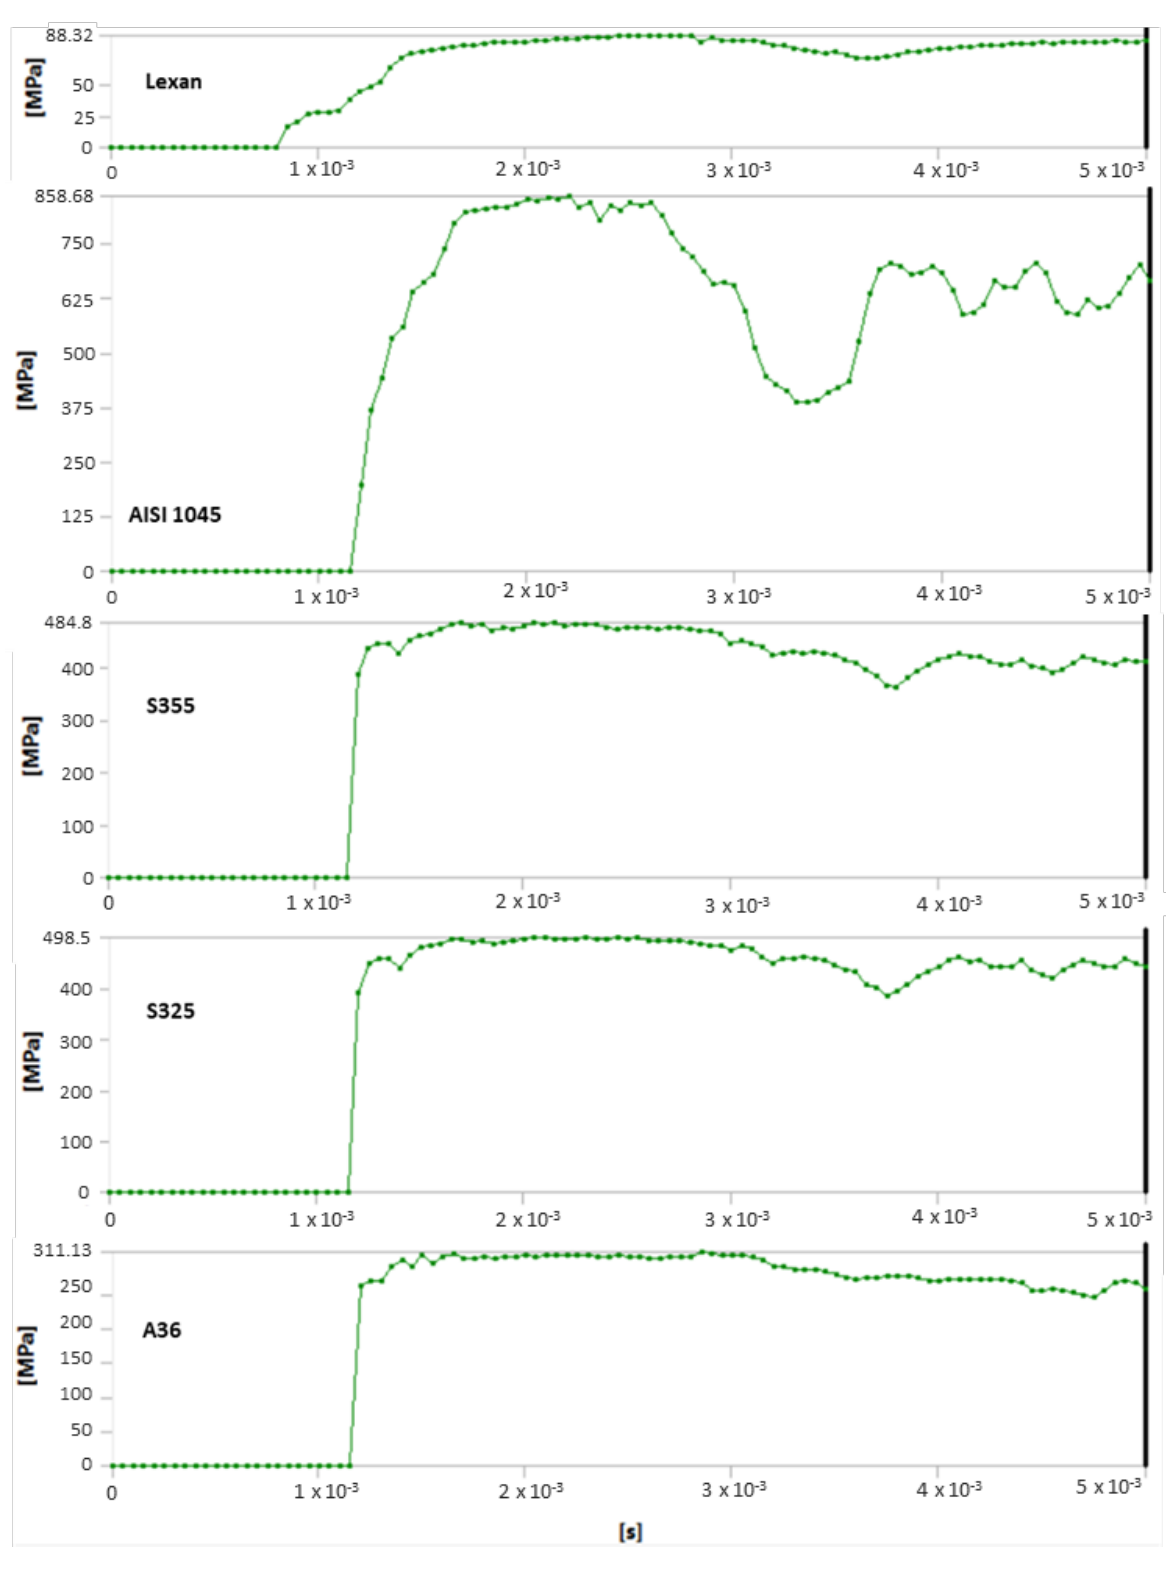
Figure 8. Huber – von Mises equivalent stress-over-time diagrams for the studied models. Figure 8. Huber–von Mises equivalent stress-over-time diagrams for the studied